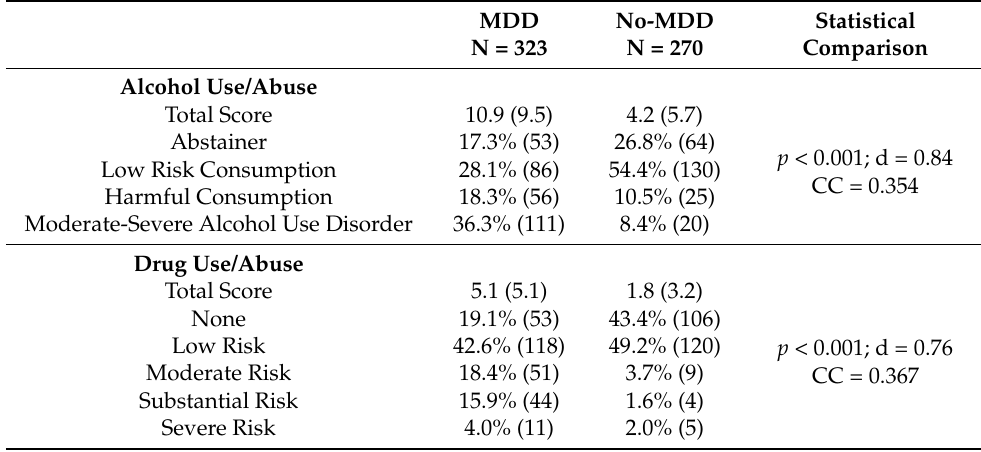
Table 3. Substance Use Behaviors